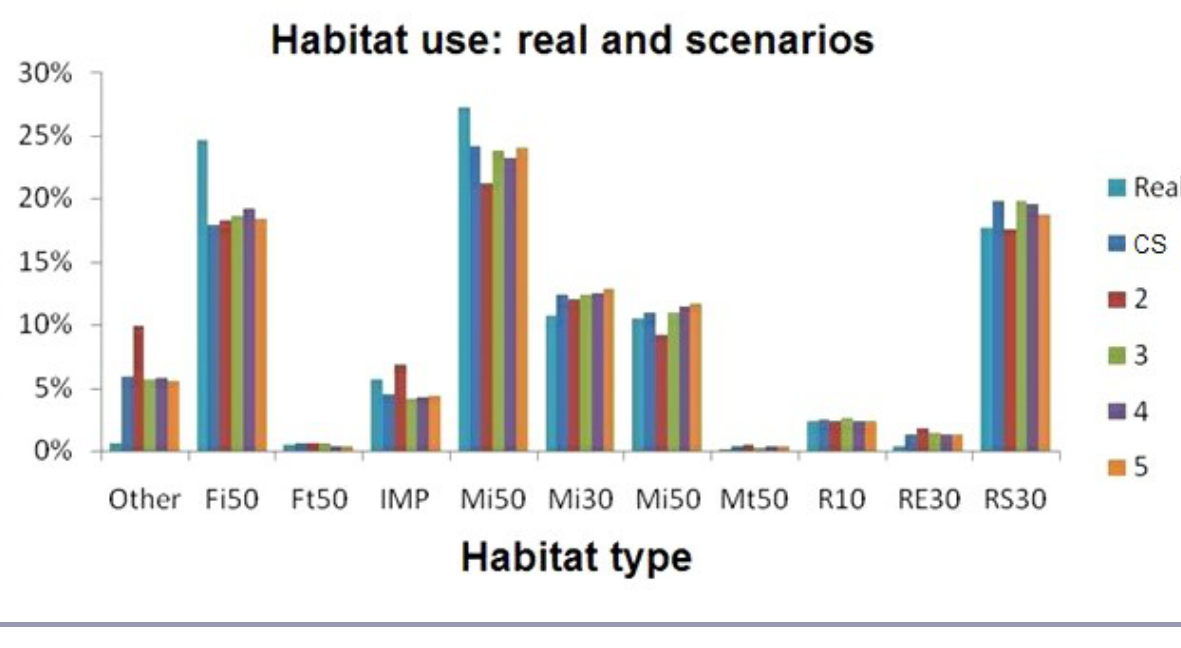
Fig. 9 . Habitat use by moose for the time period 1 May–31 August as determined using GPS-collared individuals (real) and as predicted with the five different modeling scenarios for the Laurentides Wildlife Reserve. See Table 1 for a description of habitat